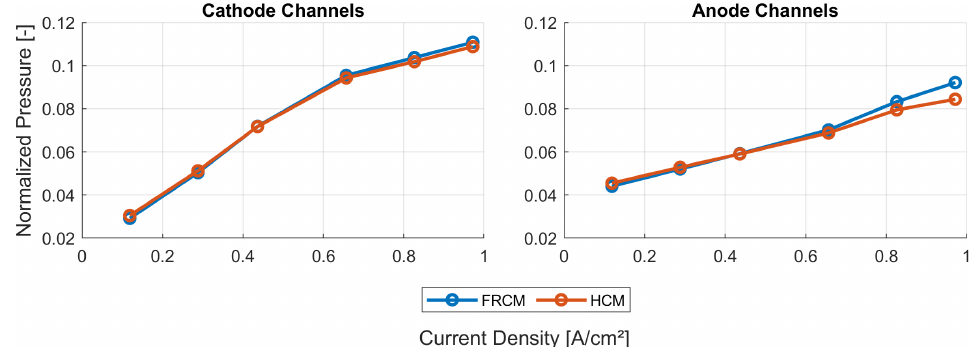
Figure 7. Comparison of normalized pressure drop in cathode and anode channels between FRCM and HCM. The values were normalized to the inlet pressure of cathode and anode.